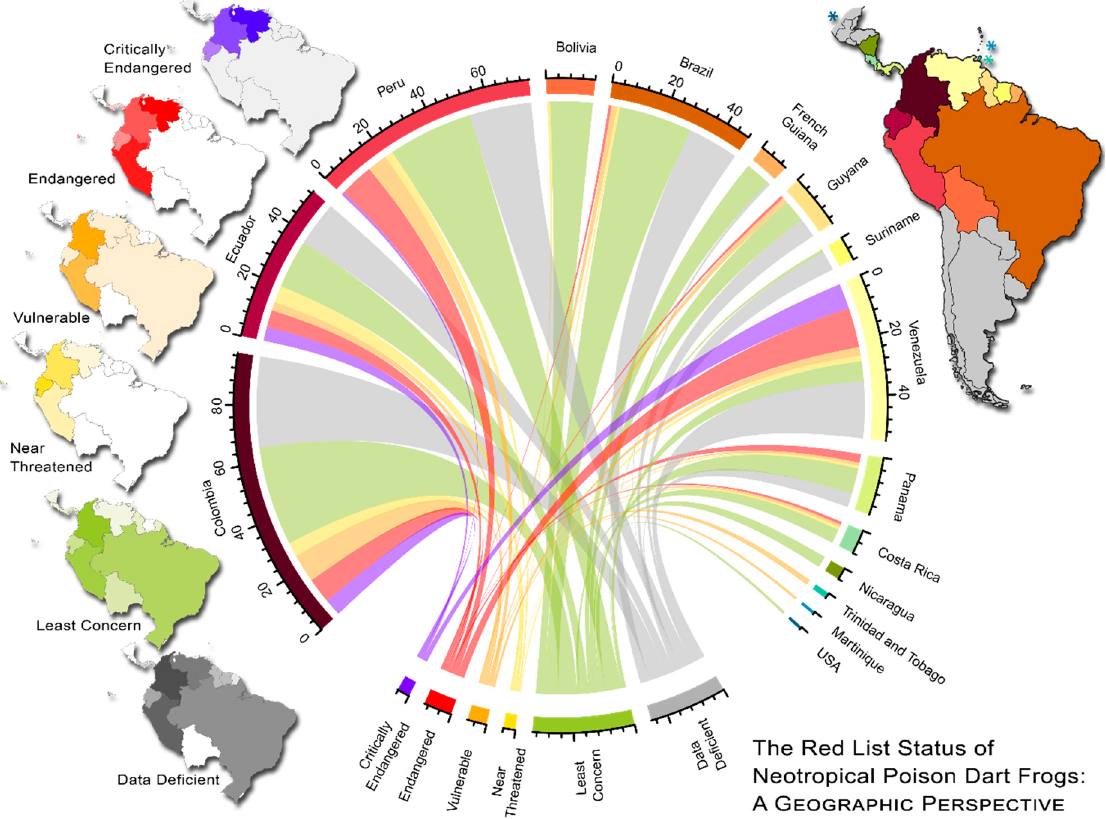
Figure 3. A geographic perspective of the Red List status of Aromobatidae and Dendrobatidae. The species composition of each country is characterized by ribbons connected to the current Red List status for each species (bottom). The numerical values below each country name depict the number of species with the associated Red List status. Bars on the outer ring depict the corresponding color of that country on the main map (top right). Maps to the left display Red List groups, where the intensity of color depicts larger number of species. If a species exists in more than one country, it was represented in each country of occurrence in the plot.